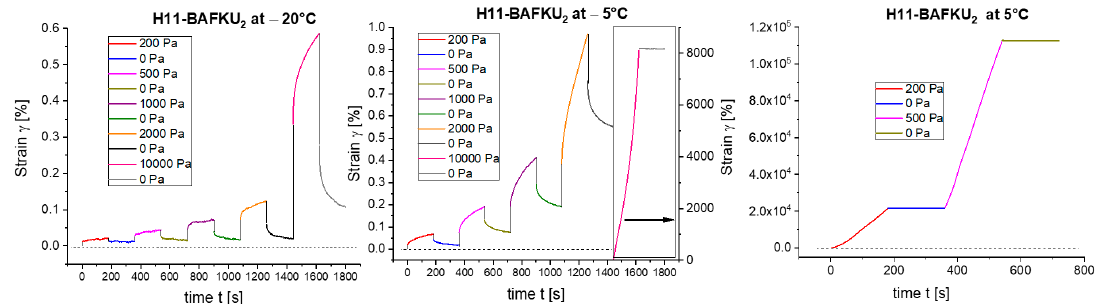
Figure 7. Multi-step creep tests of H11–BAFKU 2 at the temperatures of − 20, − 5 and + 5 ◦ C; stresses ranging between 200 and 10,000 Pa were applied, followed by recovery steps (at 0 Pa); more results at di ff erent temperatures are shown in Figure Figure 7.